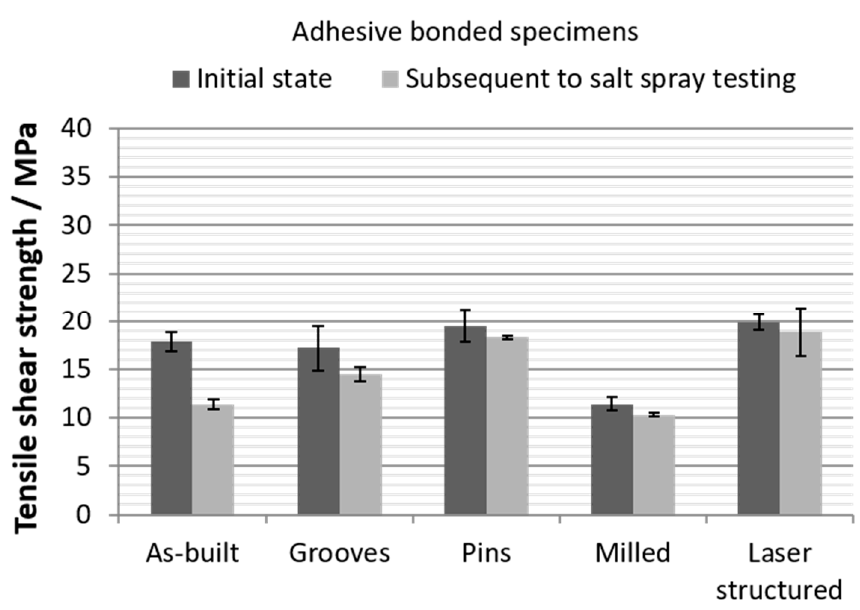
Figure 6. Tensile shear strength of adhesive bonded specimens in the initial state and after salt spray testing for 1000 h .